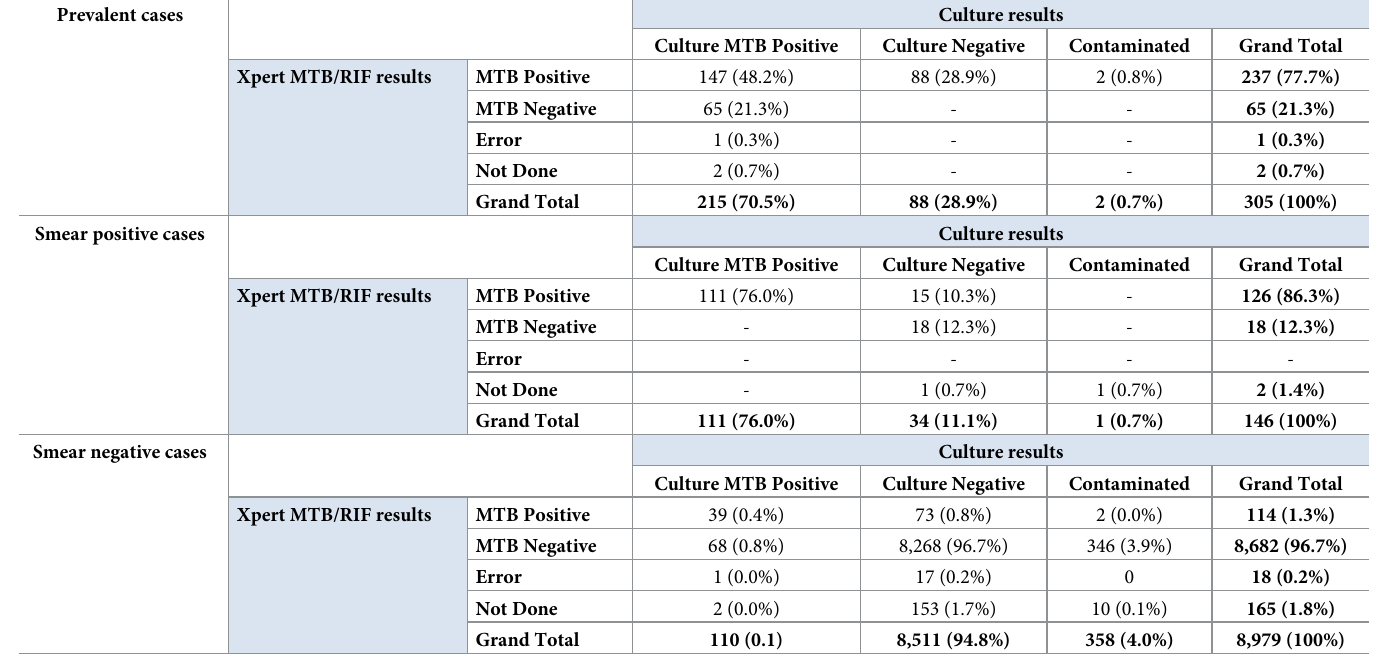
Table 7. Comparison of TB yield by diagnostic methods among the 305 prevalent cases.